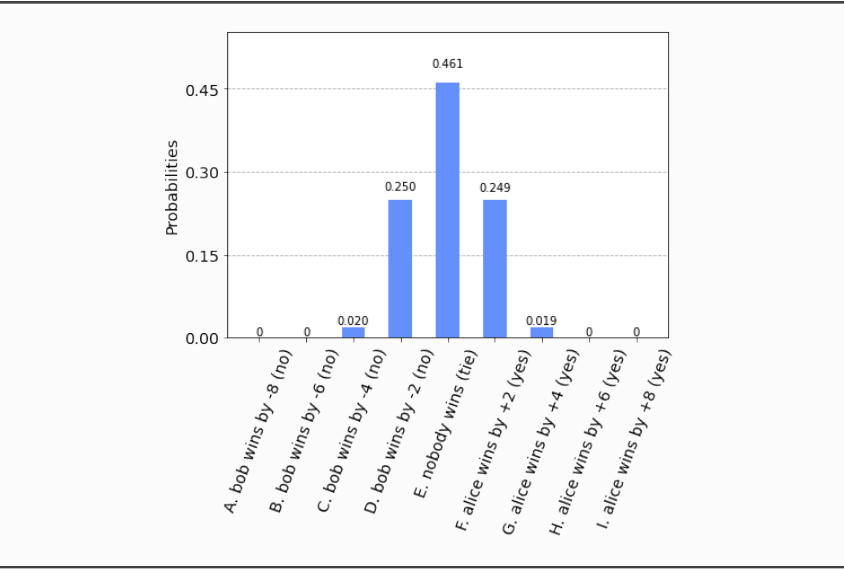
Figure 26. The possible outcomes when n A = n B = 6, r A = r B = 0.2, and n I =